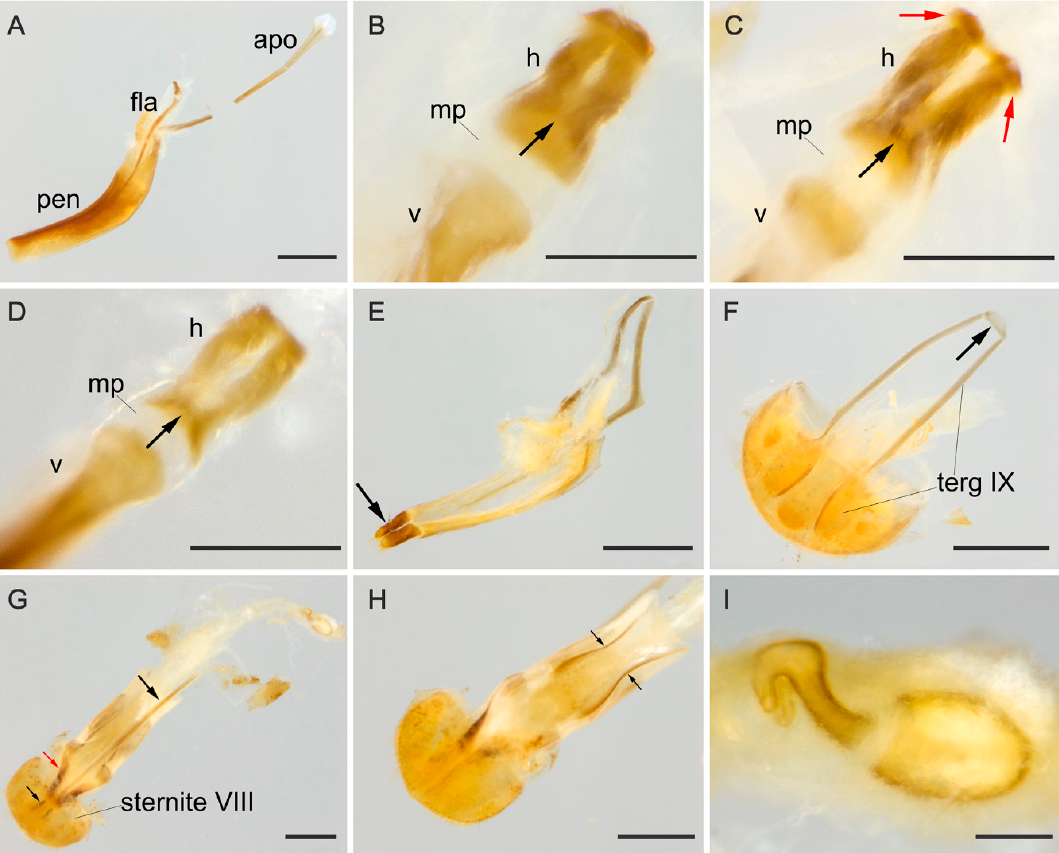
Figure 2. ( A–F ) Male abdominal terminalia of Mycotretus tigrinus Oliver, 1792 from different localities: ( A – B, E – F ) Tefé, AM, Brazil; ( C ) Linhares, ES, Brazil; ( D ) Rio Toro, Peru. ( A ) lateral view of the aedeagus, showing apophyses (apo), flagellum (fla) and penis (pen). ( B – D ) Dorsal view of flagellum showing: head (h), anterior tip of virga (v) and the membranous portion (mp); black arrows showing a posterior arcuate sclerotization and red arrows (in C) showing an anterior outer sclerotization, forming two narrowed tips. ( E ) Tegmen, arrow showing parameres; ( F ) abdominal segments VIII–X: laterotergite IX (terg IX), arrow showing the sclerite at the anteroventral edge of segment IX. ( G – I ) Female abdominal terminalia of a specimen from Parque Nacional do Xingu, MT, Brazil: ( G ) dorsal view, with small black and red arrows showing a gonostylus and a gonocoxite, respectively; big black arrow showing the median strut of sternite VIII; ( H ) ventral view, arrows showing baculi of paraprocts; ( I ) spermatheca. Scale bars: A , E – H = 0.5 mm; B – D , I = 0.1 mm.